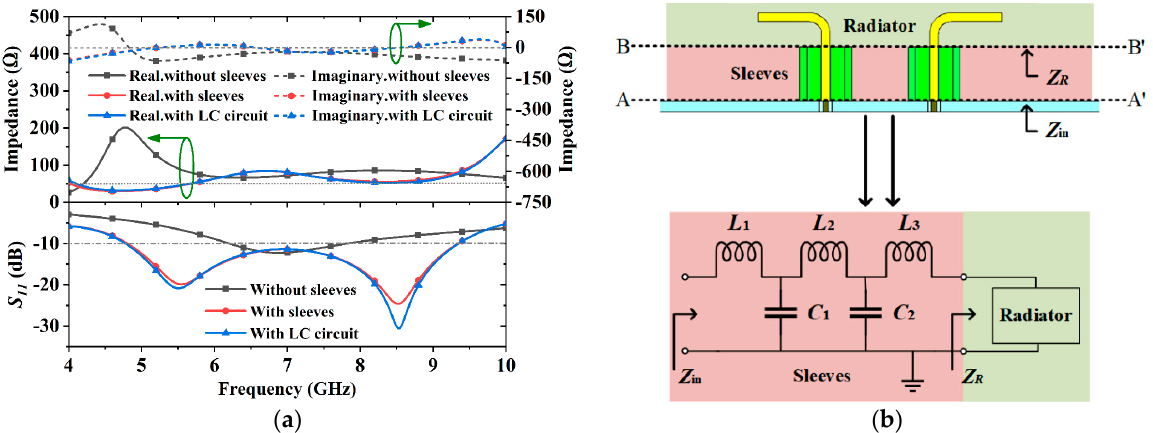
Figure 3. ( a ) Impedance and S 11 when the antenna has the double-sleeve or not. ( b ) Equivalent circuit model of the antenna.